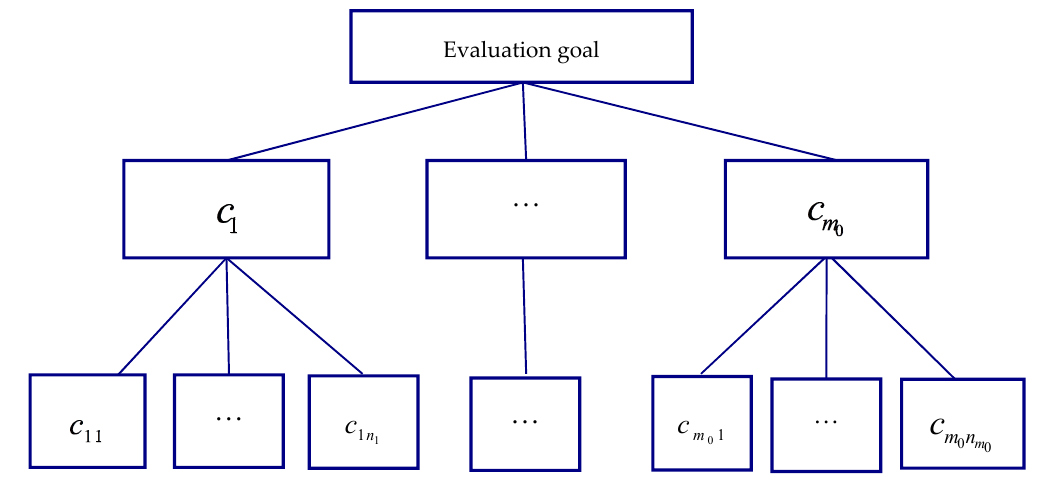
Figure 1. A hierarchical structure.